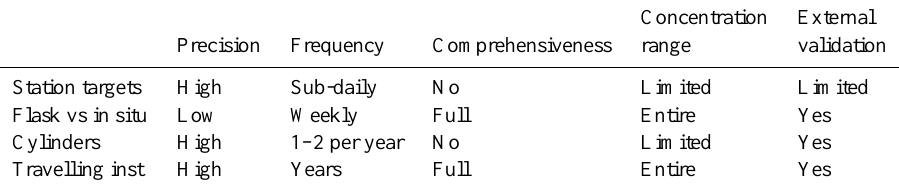
Table 3. Classification of existing quality management approaches according to the predefined quality management characteristics